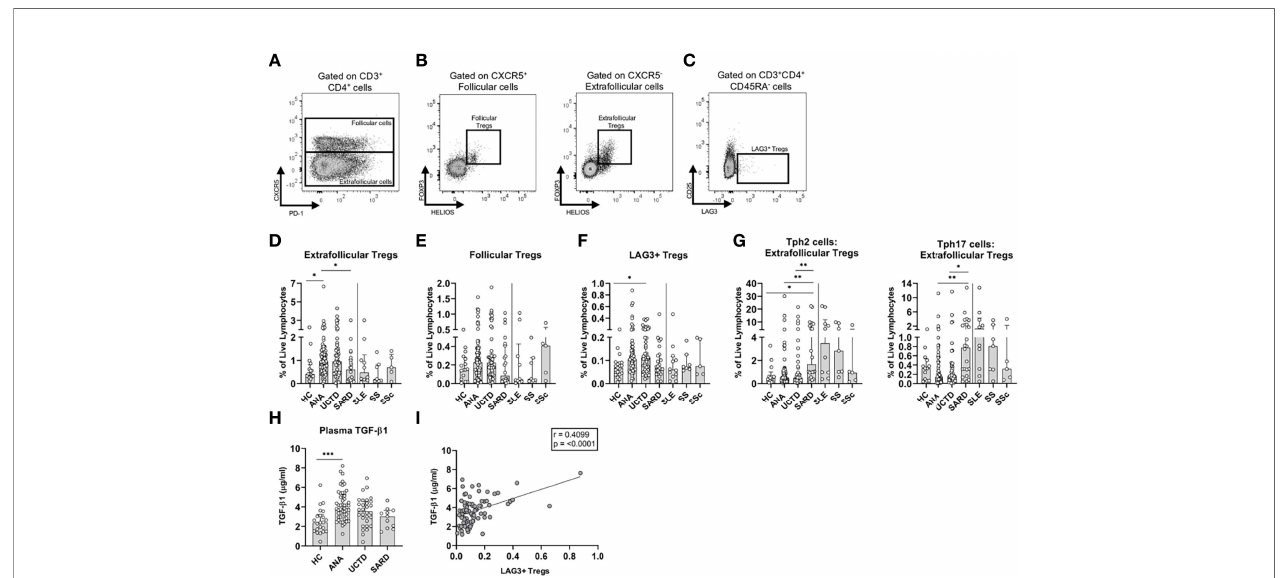
FIGURE 2 | T regulatory (Treg) subsets and transforming growth factor beta-1 (TGF- b 1) are increased in anti-nuclear antibody positive (ANA + ) individuals lacking a systemic autoimmune rheumatic diseases (SARD) diagnosis. (A) Gating strategy for identi fi cation of (CD3 + CD4 + ) follicular (CXCR5 + ) and extra-follicular (CXCR5 - ) T cells for a representative ANA + patient. Gating strategy for identi fi cation of (B) (HELIOS + FOXP3 + ) follicular and extra-follicular Tregs and (C) memory (CD45RA - ) LAG3 + T regulatory cells (LAG3 + Tregs, LAG3 + CD25 - ). (D – F) The proportions of Treg subsets strati fi ed by subject group. (G) The ratio of memory T peripheral helper 2 cells to extra-follicular Tregs; and the ratio of memory T peripheral helper 17 cells to extra-follicular Tregs strati fi ed by subject group on a log10 scale. (H) Plasma TGF- b 1 levels strati fi ed by subject group. (I) The correlation between the proportion of memory LAG3 + Tregs and TGF- b 1 levels. The solid vertical line in each plot separates the groups that were statistically compared to one another from the individual SARD on the right, which were not statistically compared to any group. Bars represent the median with interquartile range. Each data point represents an individual subject. Statistical signi fi cance was determined using the Kruskal-Wallis test with Dunn ’ s post-hoc test for multiple comparisons; *p ≤ 0.05, **p ≤ 0.01, ***p ≤ 0.001. The strength of association was determined using a non-parametric Spearman correlation analysis. The solid line of best fi t was computed from linear regression. HC, ANA - healthy control; ANA, asymptomatic ANA + ; UCTD, undifferentiated connective tissue disease; SARD, systemic autoimmune rheumatic disease; SLE, systemic lupus erythematosus; SS, Sjögren ’ s syndrome; SSc, systemic